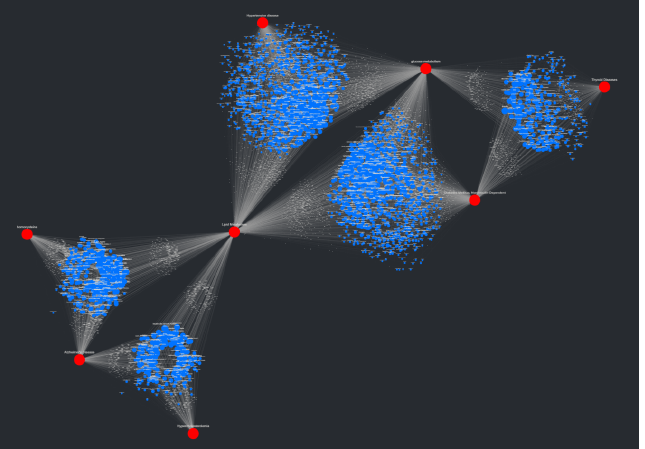
Figure 4. The adjusted spring graph layout using the same SemNet test data from Figure 3 (runtime: 5.78